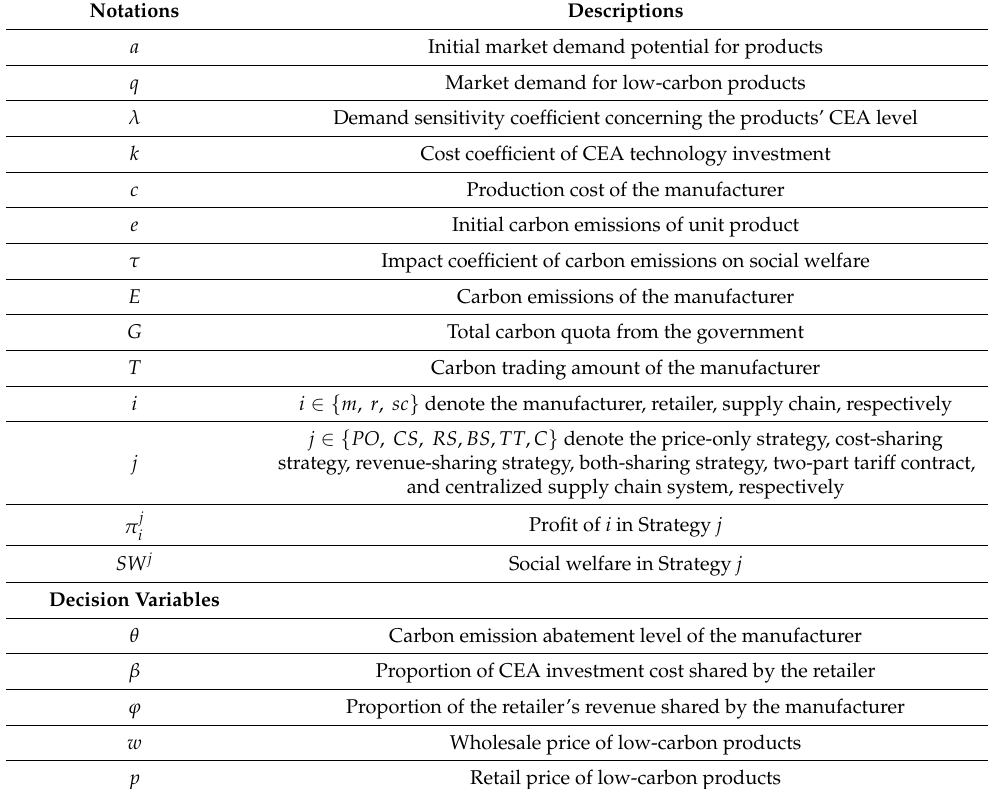
Table 2. Symbols and notations used in this